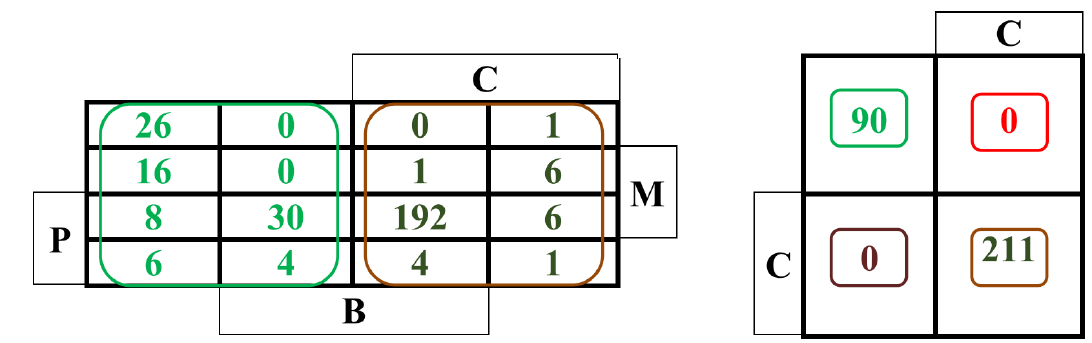
Fig. 2. Map additive elimination of 𝑁 ( 𝐶 , 𝐵 , 𝑃, 𝑀) with respect to 𝐵, 𝑃, and 𝑀 to obtain the contingency table of 𝐶 with respect to itself